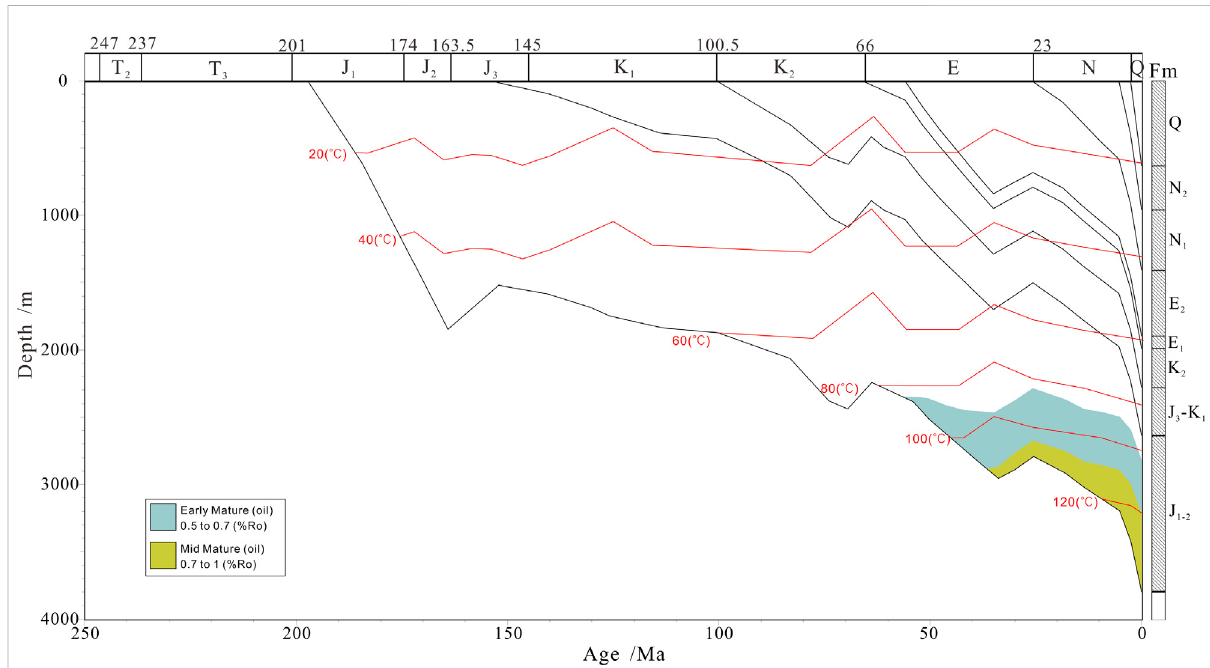
Burial history and thermal evolution of the Well FZ10 (location is shown in Figure 1). The fi ll colors represent different stages of maturity evolution. The J 1-2 label represents the Early – Middle Jurassic; J 3 -K 1 represents the Late Jurassic – Early Cretaceous; K 2 represents the Late Cretaceous; E 1 represents the Paleocene; E 2 represents the Eocene; N 1 represents the Miocene; N 2 represents the Pliocene; and Q represents the